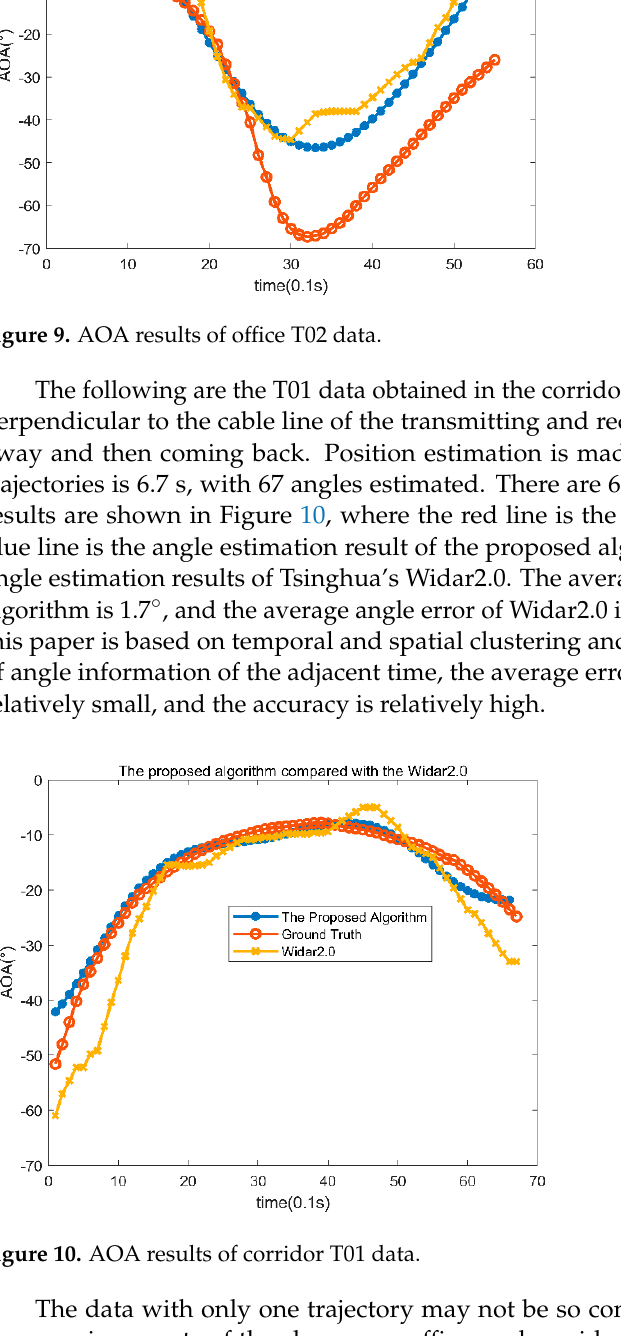
Figure 11. Cumulative angle error of the corridor.